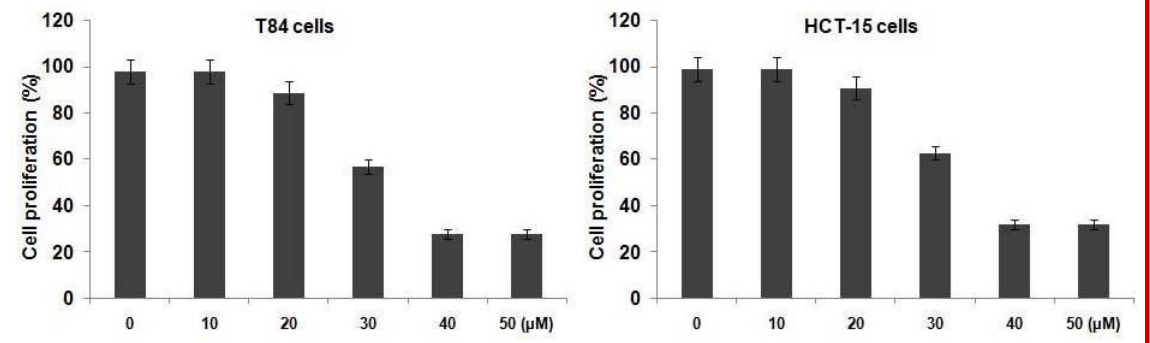
Figure 1: Trolox treatment inhibits proliferation of T84 and HCT-15 human colon cancer lines after 24 hours. The cell lines were exposed to a range of trolox concentrations from 10-50 µM for 24 hours